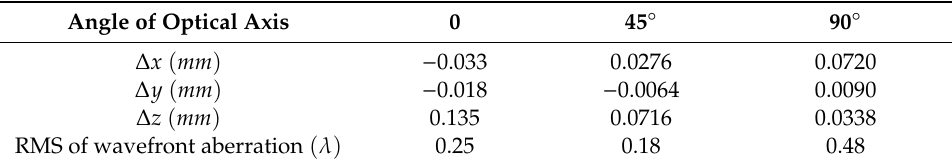
Figure 3. Misalignment curve as a function of angle. Table 2. Secondary mirror misalignment and wavefront